Question: Condense the content of this figure into a single sentence.
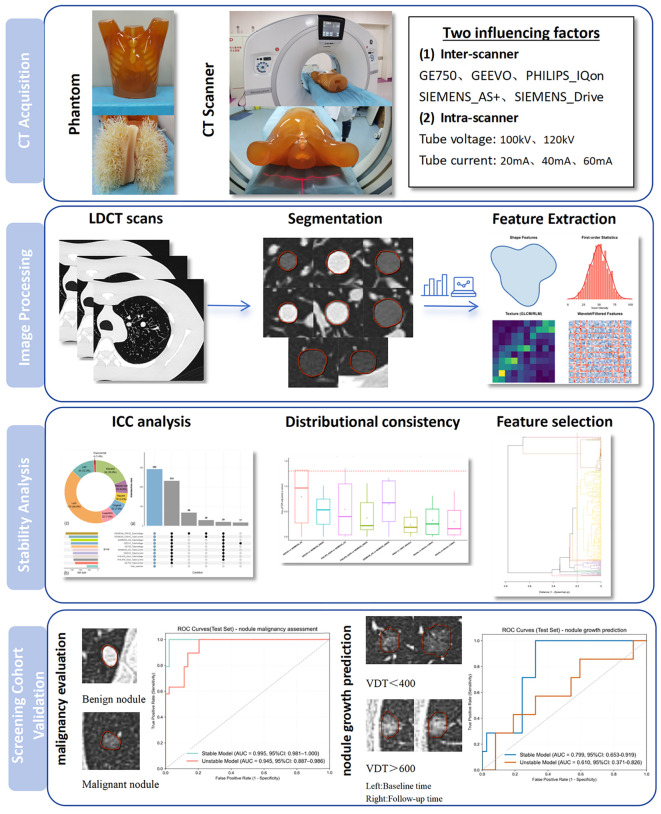
Answer: Overview of the study workflow. The study workflow consisted of four main stages: CT acquisition, image processing, stability analysis, and validation. A phantom containing eight nodules with different densities was scanned on five CT scanners using lung cancer screening acquisition parameters, after which radiomics features were extracted. Feature stability was assessed using intraclass correlation coefficients, distribution consistency analysis, and clustering. The selected stable features were subsequently used for malignancy assessment and nodule growth prediction, and their clinical utility was evaluated through comparison with models constructed using the remaining unstable features. VDT, volume doubling time; GE750, Discovery CT750 HD (GE); GEEVO, Revolution EVO (GE); PHILIPS_IQon, IQon Spectral CT (Philips); SIEMENS_AS+, SOMATOM Definition AS+ (Siemens); SIEMENS_Drive, SOMATOM Drive (Siemens).